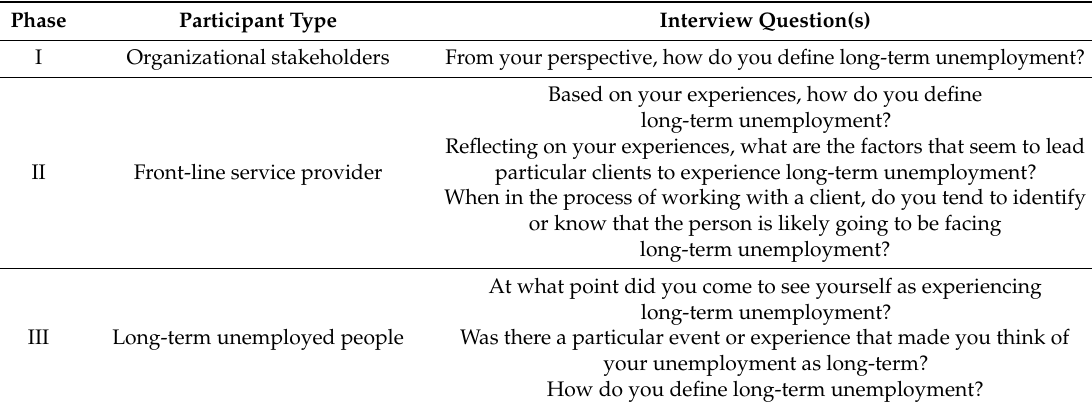
Table A1. Interview Questions for Eliciting Definitions of Long-term